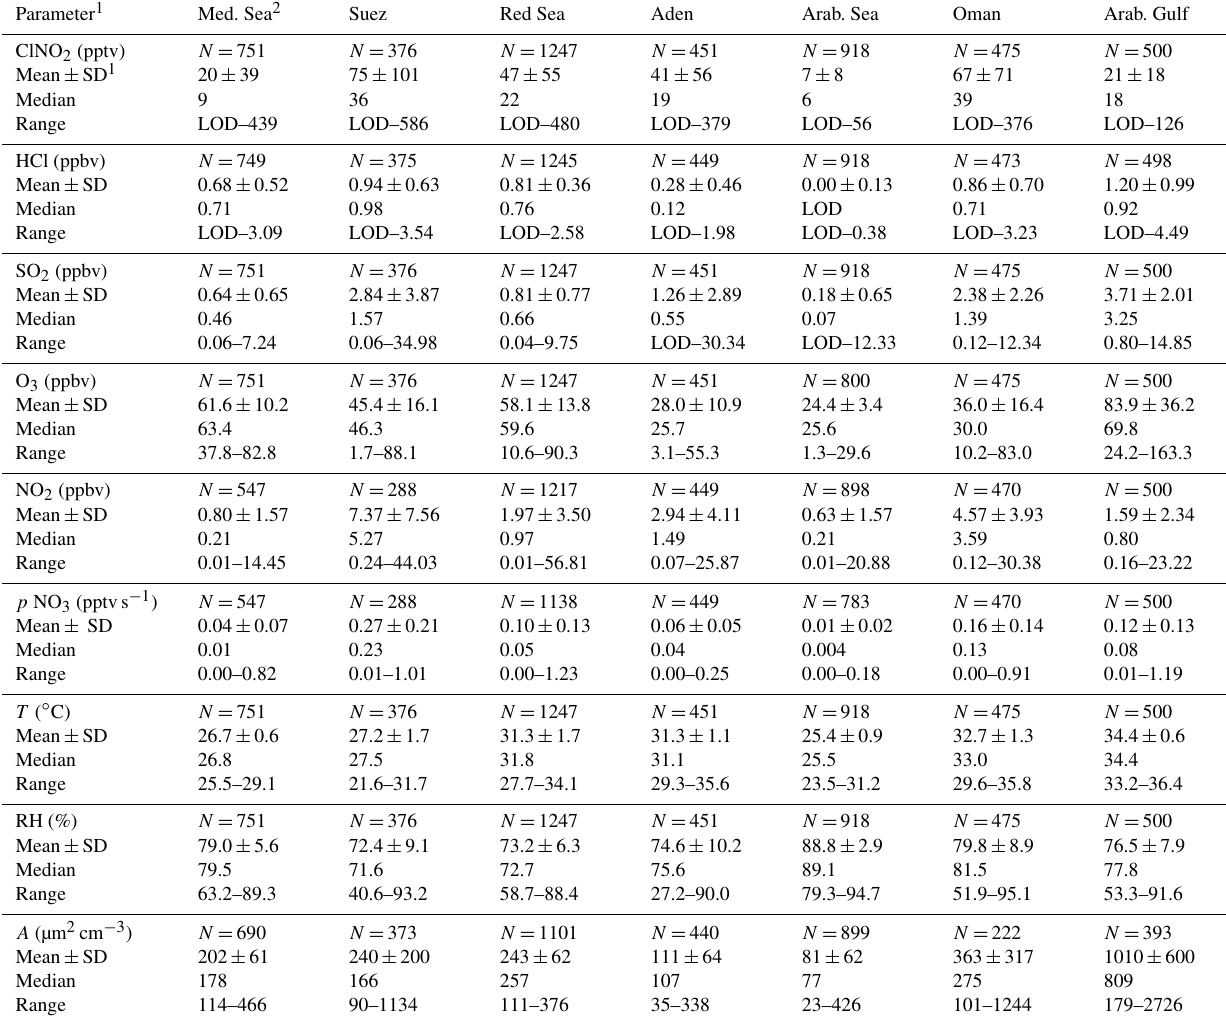
Table 1. Measured trace gases and other parameters (5min, night-time only) for the different regions indicated in Fig. 2. Parameter